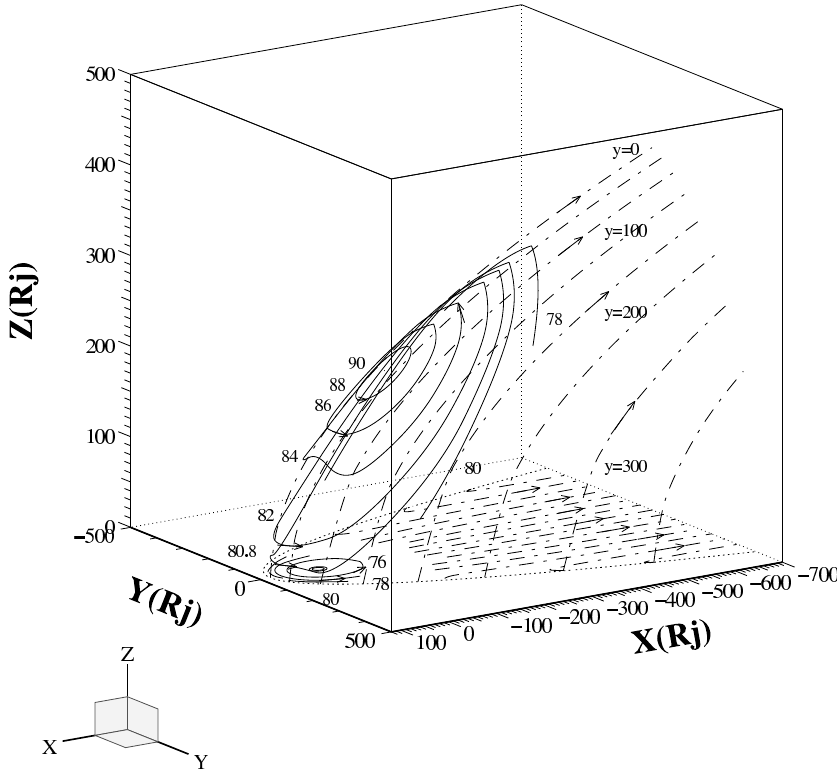
Fig. 13. Three-dimensional Jovian magnetosphere for northward IMF. Equipotentials of the corotation (solid curves) and of the solar wind (dash-dotted curves) electric field on the magnetopause and on the equatorial plane. The IMF components are: B 0x =− 0 . 02nT, B 0y = 0, B 0z = 0 . 5nT; the coefficient of IMF penetration is k J = 1. For the dash-dotted curves, δy = 50 R J and δU = 0 . 75MV. For the solid curves on the equatorial plane (from the outer to inner) the latitudes and electric corotation potentials are: 80 ◦ , 0 . 4MV; 78 ◦ , 1 . 4MV; 76 ◦ , 4 . 3MV; 74 ◦ , 7 . 6MV; 0 ◦ , 356MV, respectively. For the solid curves on the magnetopause (from the outer to inner) the corresponding values are: 81 ◦ , 0MV; 82 ◦ , –1.9MV; 84 ◦ , –5.1MV; 86 ◦ , –7.4MV; 88 ◦ , –8.8MV; 90 ◦ , –9.2MV, respectively.